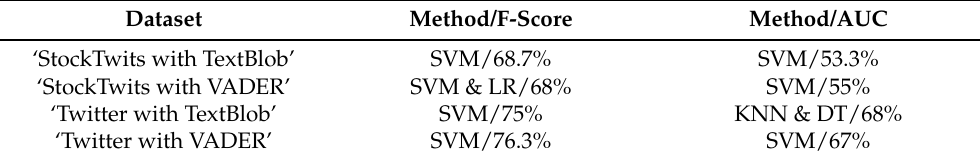
Table 12. Best results per dataset.